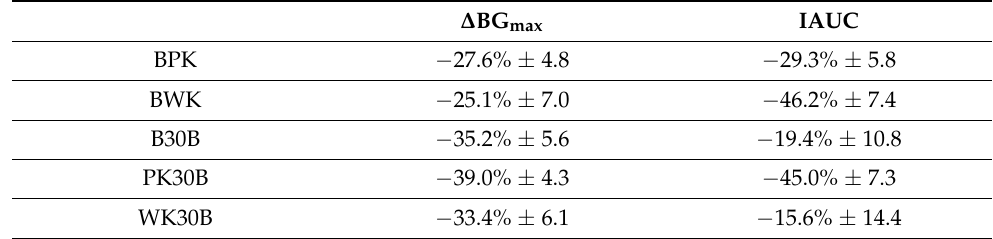
Values are shown as mean ± SEM ( n = 12). *: p < 0.05 vs. B, **: p < 0.01 vs. B (Dunnett’s test). Table 4. Suppression rate of ∆ Blood Glucose levels. Table 4. Suppression rate of ΔBlood Glucose levels.